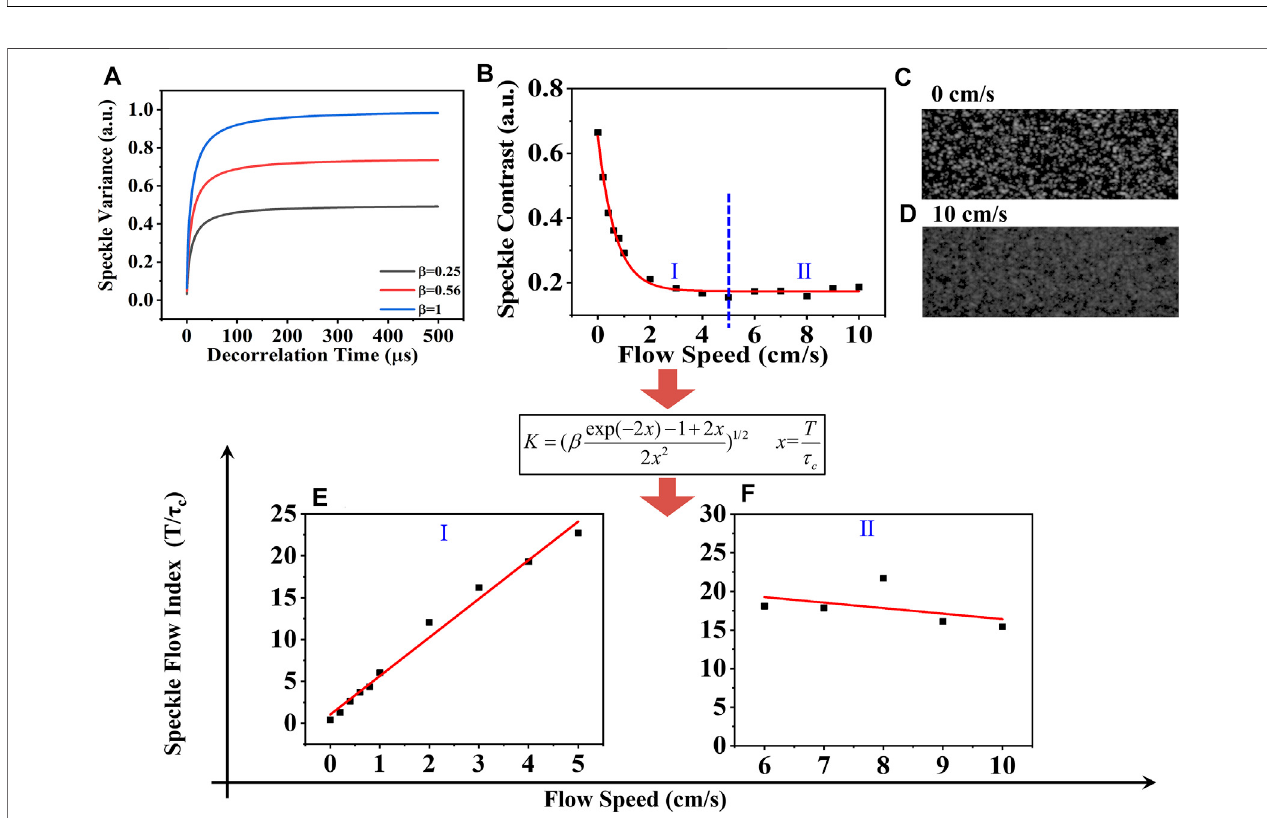
FIGURE2|(A) Specklecontrastasafunctionofthedecorrelationtime τ c by Eq.2 . (B) Specklecontrastvarieswiththedifferent fl owvelocities. (C) and (D) Speckle patterns at 0 cm/s and 10 cm/s. The relationship between the SFI and the actual velocity in the range from (E) 0 cm/s to 5 cm/s and (F) 5 cm/s to 10 cm/s. Black squares represent experimental data, and red solid lines represent fi tting curve.